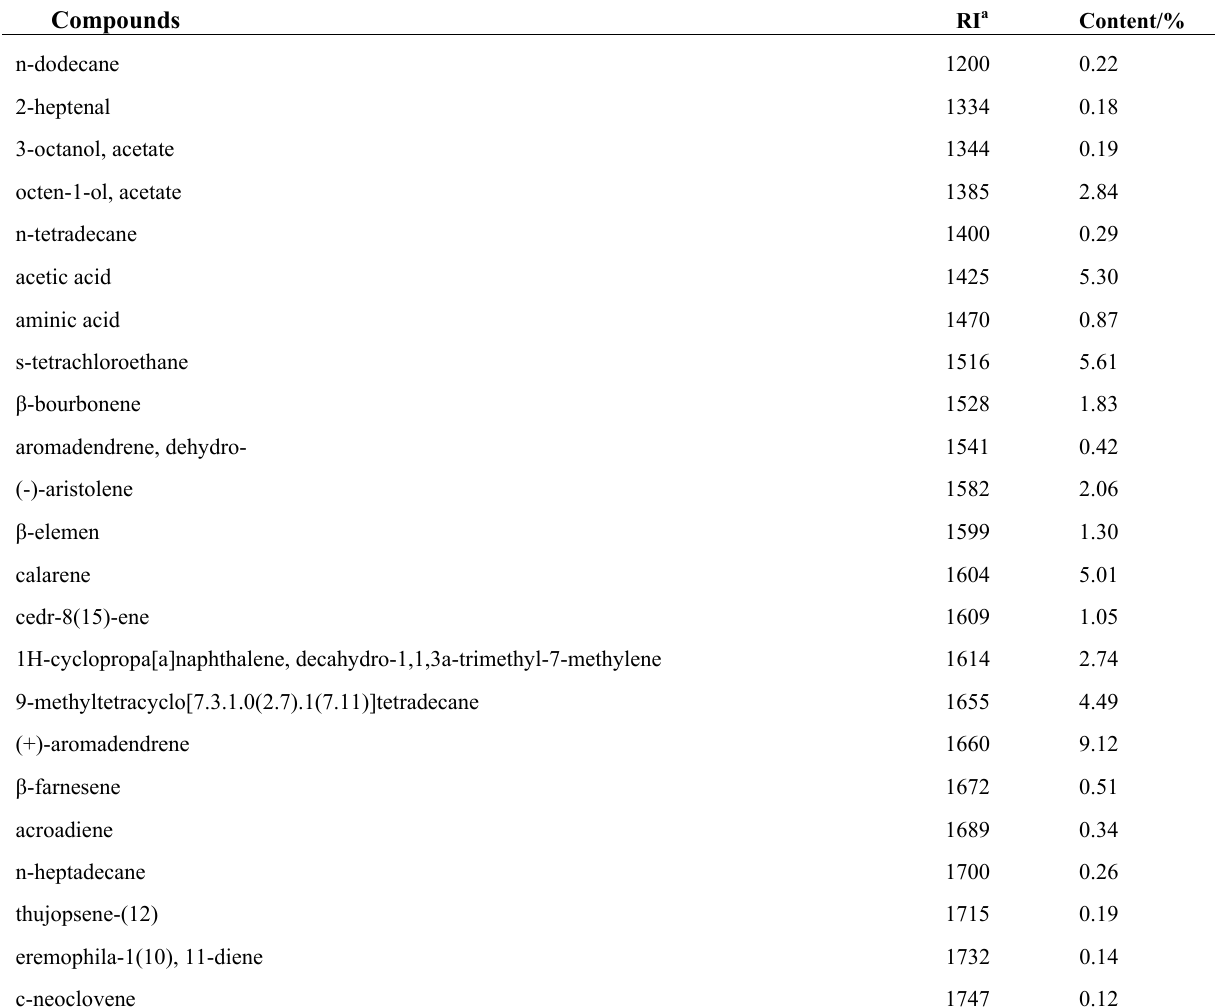
Table 1. Chemical composition of S. verrucosa